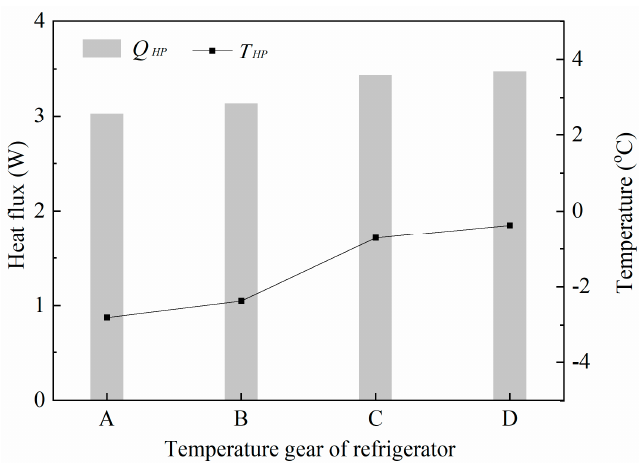
Figure 10. Heat flux and temperature of heat pipes versus temperature gear.